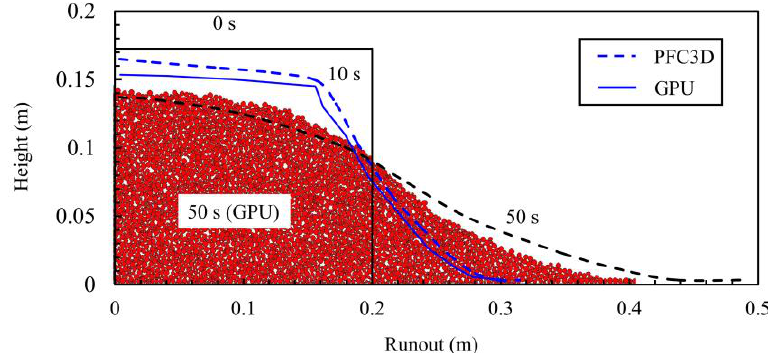
Figure 13. Runout profiles of sand grains due to dam break.